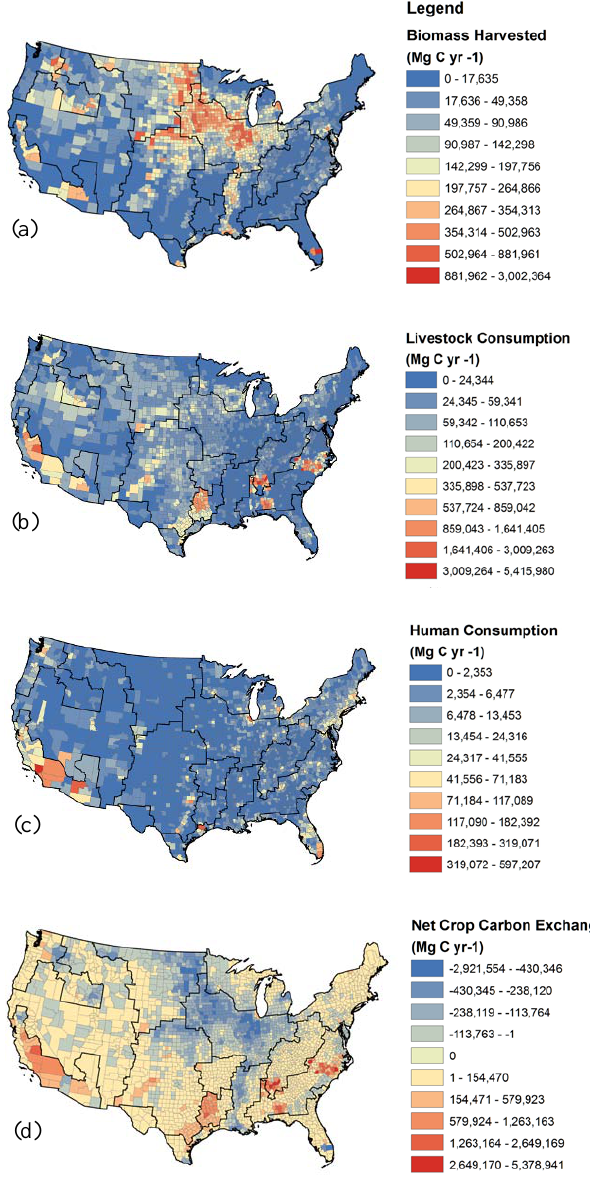
Fig. 4. Harvested biomass, approximate release of biomass car- bon from humans and livestock, and the geographic net exchange of crop carbon for 2008. Harvested biomass (a) is removed from the field and released as CO 2 by livestock and humans ( b and c ). Net exchange of crop carbon (d) is the sum of net carbon uptake by crops, net change in soil carbon, and the release of carbon through biomass decomposition and the consumption and respiration by livestock and humans. Net carbon exchange estimates represent an- nual vertical fluxes within each